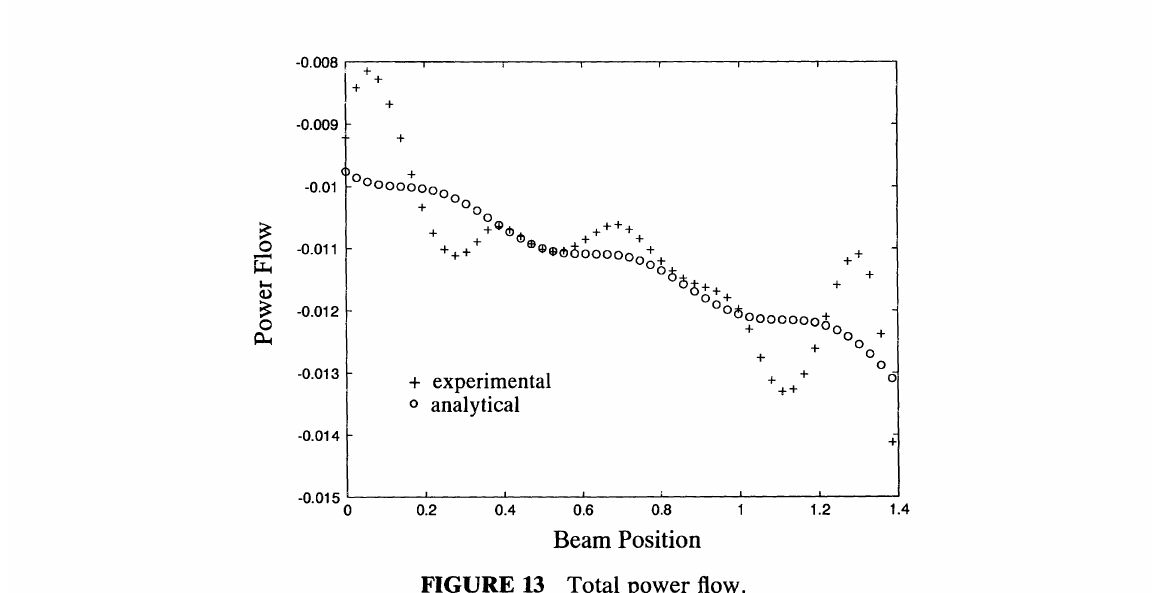
FIGURE 13 Total power